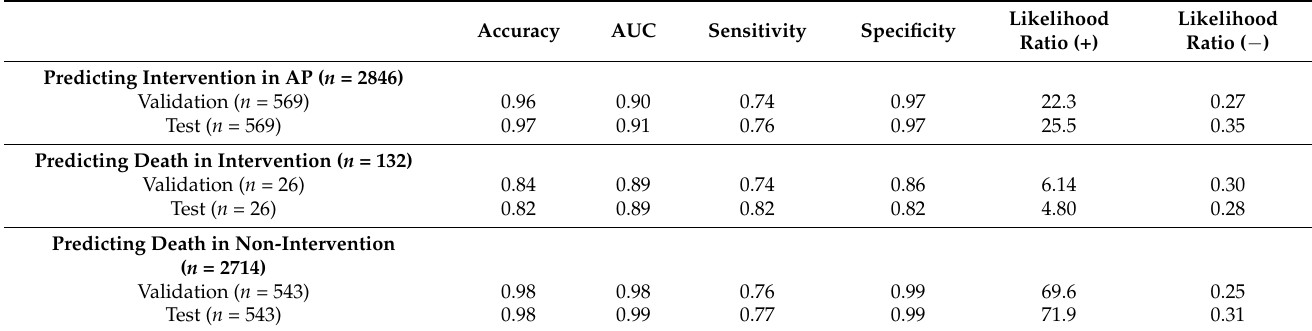
Table 3. Performance of prediction for the three groups.